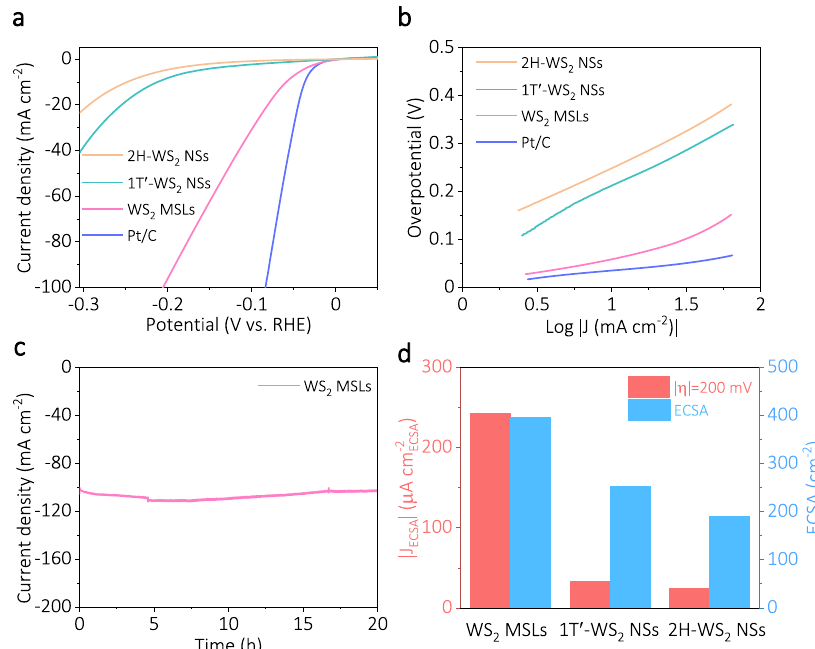
Fig. 3 Electrocatalytic application of WS 2 MSLs in HER. a Polarization curves of all catalysts with a scan rate of 10 mV s − 1 in Ar-bubbled 0.5 M H 2 SO 4 (after iR correction, normalized by geometrical surface area, Geometric electrode area: 1 cm 2 ). b The corresponding Tafel curves for catalysts derived from ( a ). c Continuous HER recorded from synthesized WS 2 MSLs as working electrodes at a static potential of − 0.2 V vs. RHE. d Comparison of the ECSA and J − 0.2 V vs. RHE) of WS ’ -WS ECSA (at 2 MSLs, 1T 2 NSs, and 2H-WS 2